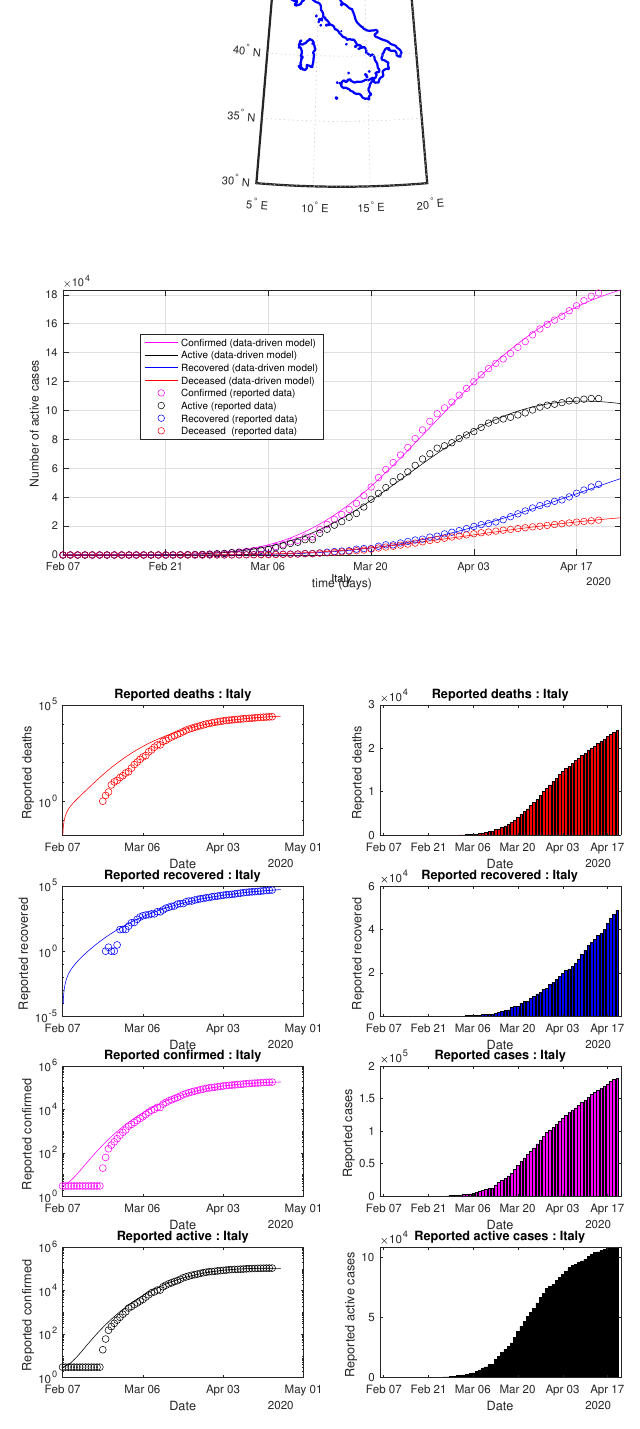
Figure 42. Italy: data of active, recovered, deceased (in circle or bar) vs. model of active, recovered, deceased over time. Tracking the number of active cases. Predictive analytics for the next couple